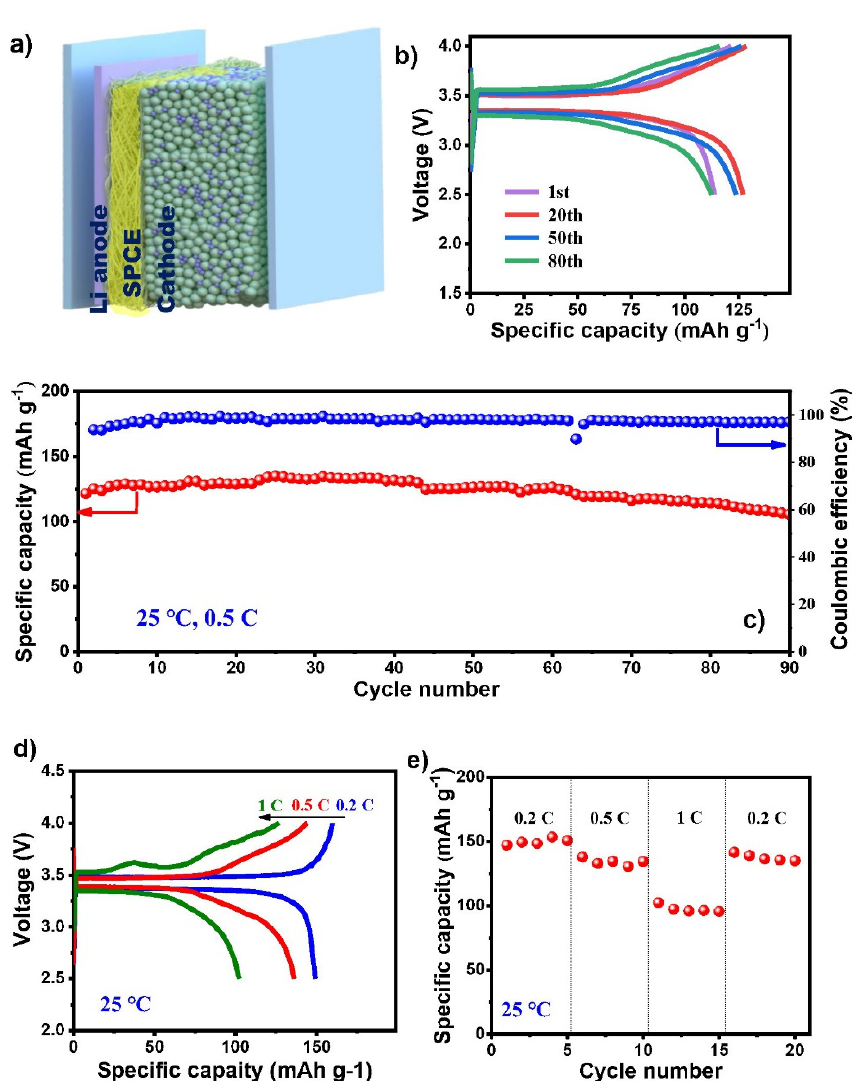
Figure 6. ( a ) Schematic diagram of the structure of LiFePO 4 ||Li solid-state battery. ( b ) Voltage profile at different cycles. ( c ) Long-term cycling performance at 0.5 C. ( d ) Voltage profiles at different cycling rate. ( e ) Rate performance of the cell. All results are collected at room temperature.